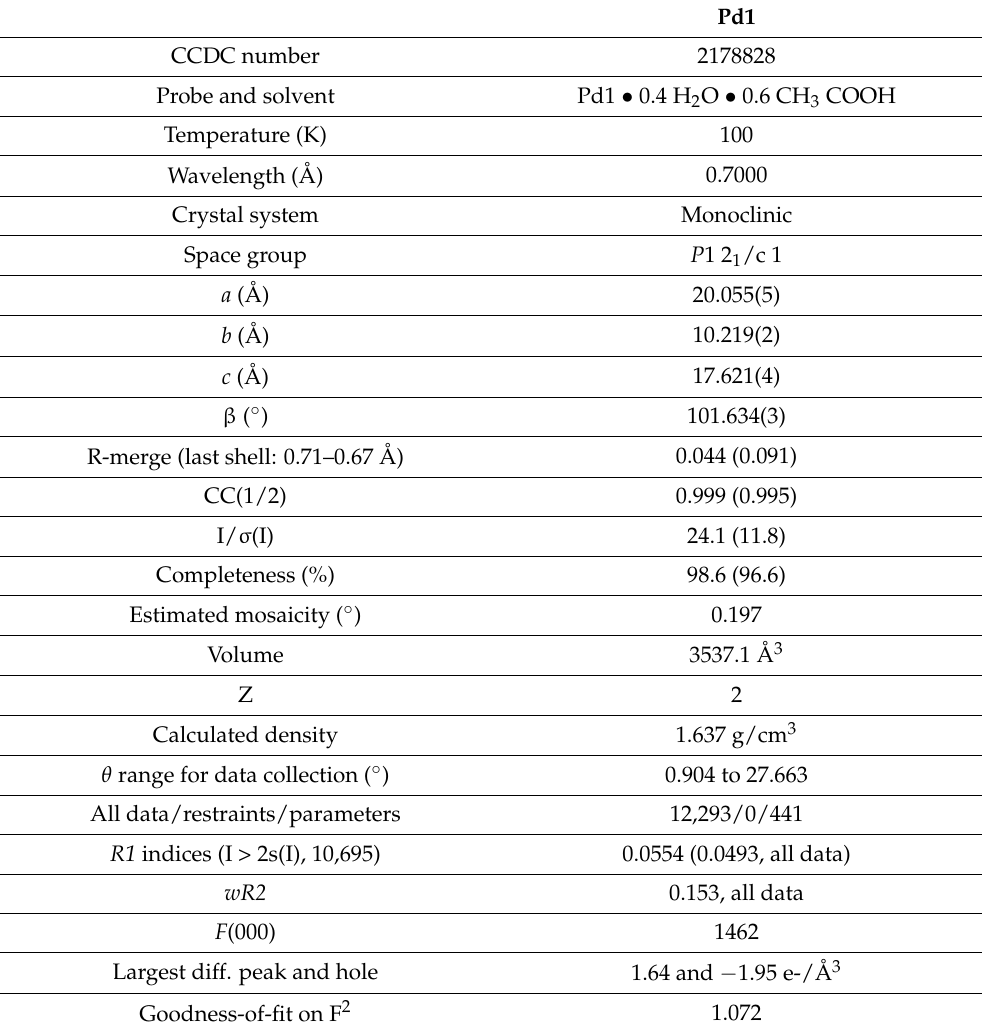
Table 2. Crystal data and structure refinement details for Pd1.